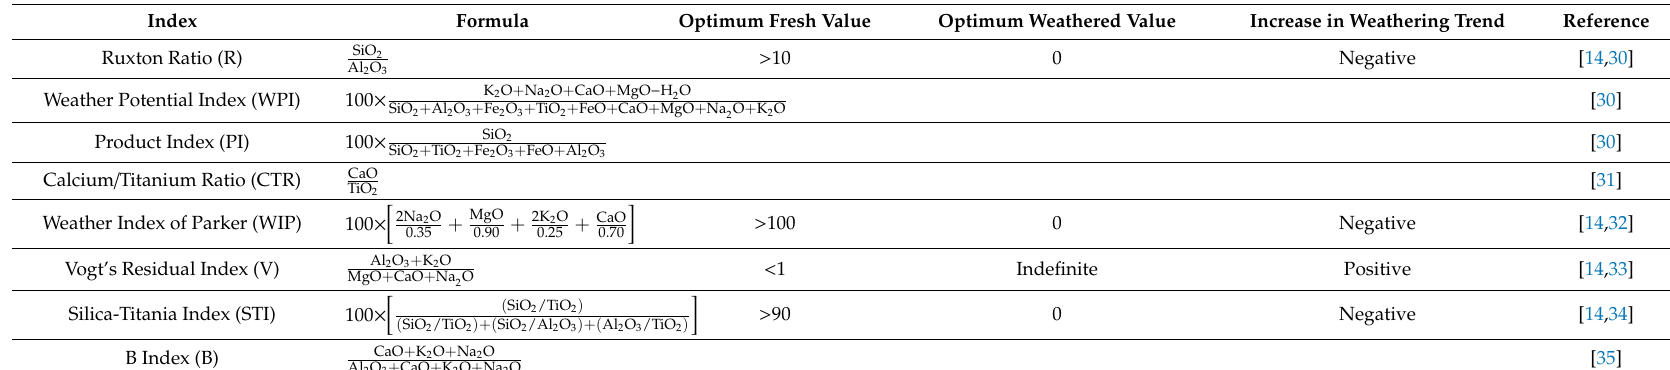
Table 2. Summary of weathering indices used in this study. The indices were calculated using molecular proportions of element oxides. Listing modified from Price and Velbel